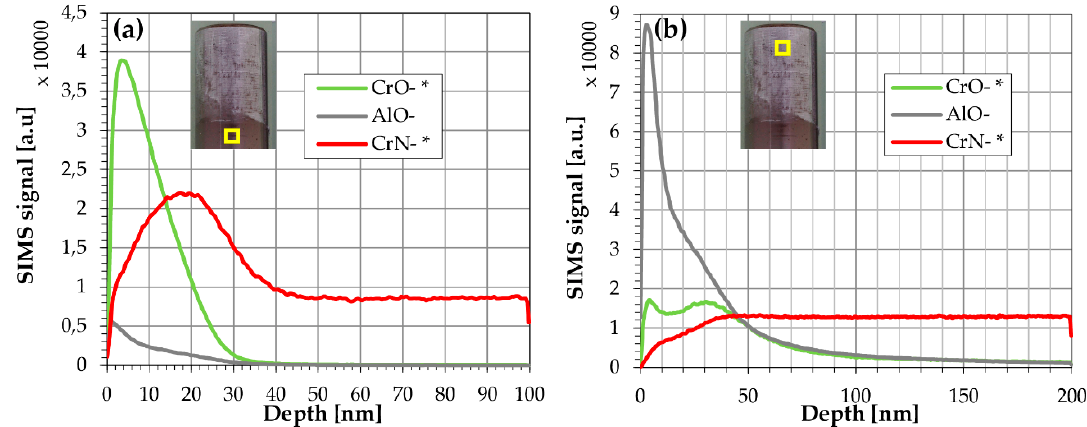
Figure 6. ToF-SIMS depth spectra of the CrN-R sample after CS experiment: ( a ) profile at the location not Figure 6. ToF ‐ SIMS depth spectra of the CrN ‐ R sample after CS experiment: ( a ) profile at the location